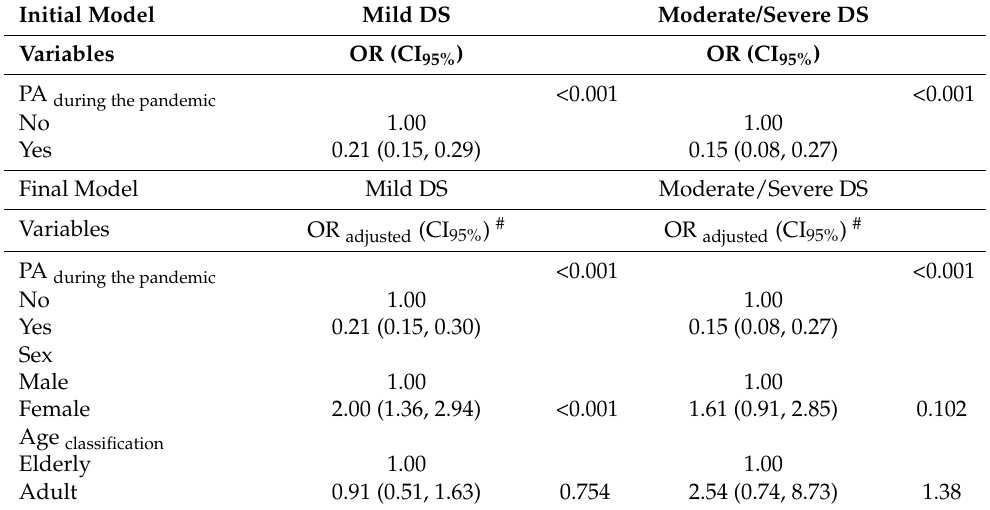
Table 2. Multinomial Logistic Regression. Depressive symptoms (DS) during the pandemic, with participants with minimal symptoms used as the reference